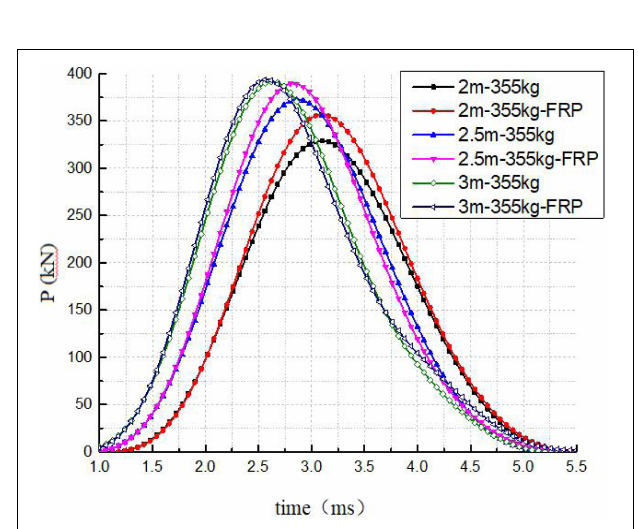
FIGURE 13 | Impact force time history curves at different heights.